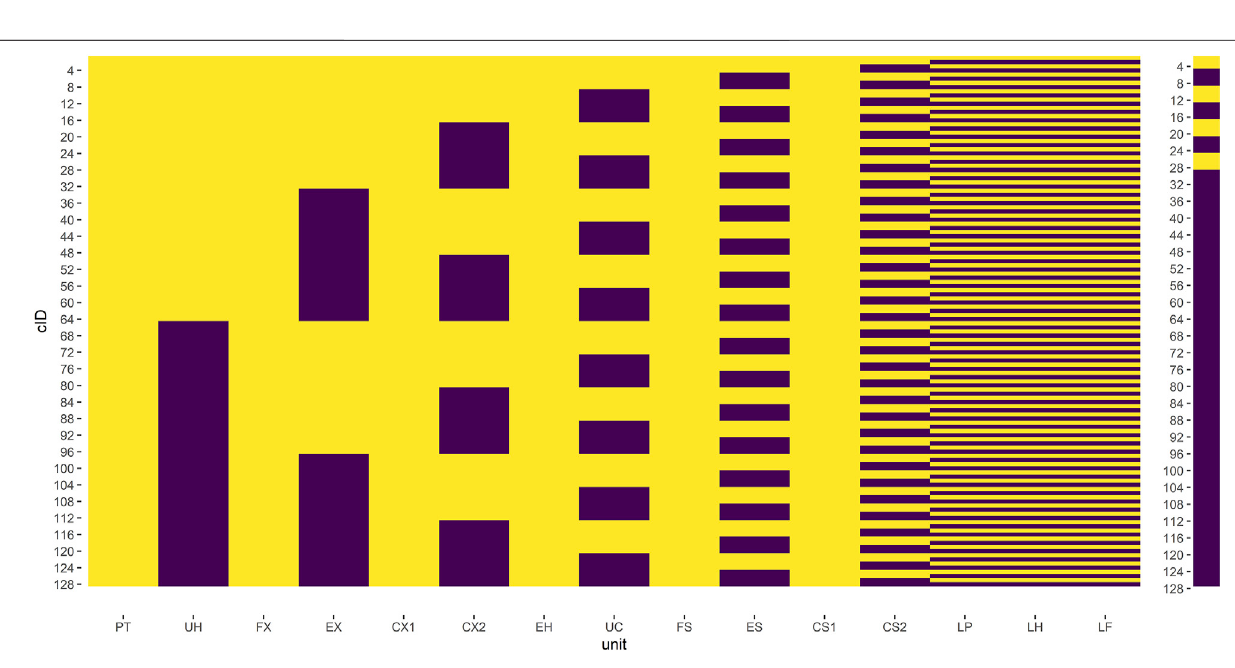
Frontiers in Chemical Engineering |